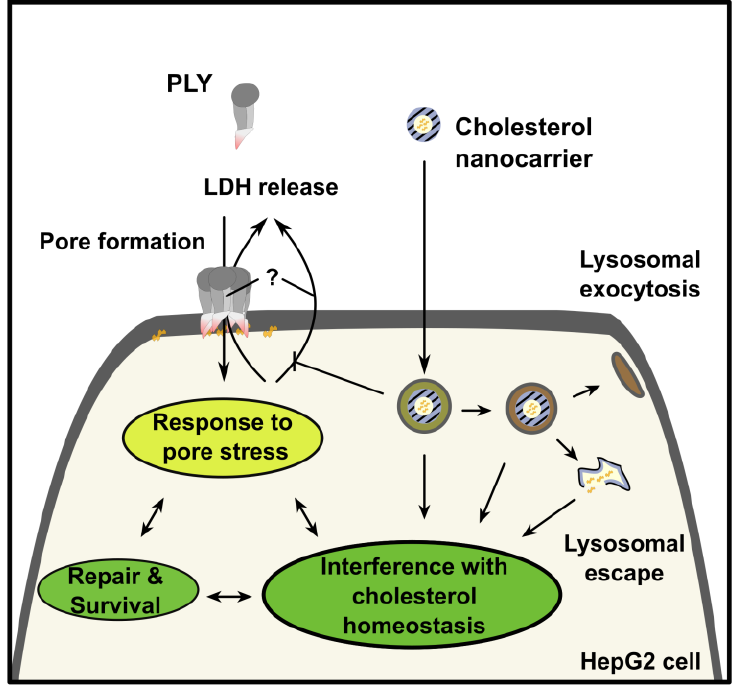
Figure 4. Interference with cholesterol homeostasis promotes cell-protective adaptation to pore formation. Intracellular cholesterol delivery promotes increased tolerance of HepG2 cells towards PLY pore-mediated plasma membrane injury and cell death. Supplementation of cholesterol by a nanocarrier such as [E100–PLGA](Chol) NP prevented PLY-induced perturbation of the cellular signaling, and the activation of crucial lipid homeostasis regulators in response to PLY can enhance cell membrane repair.